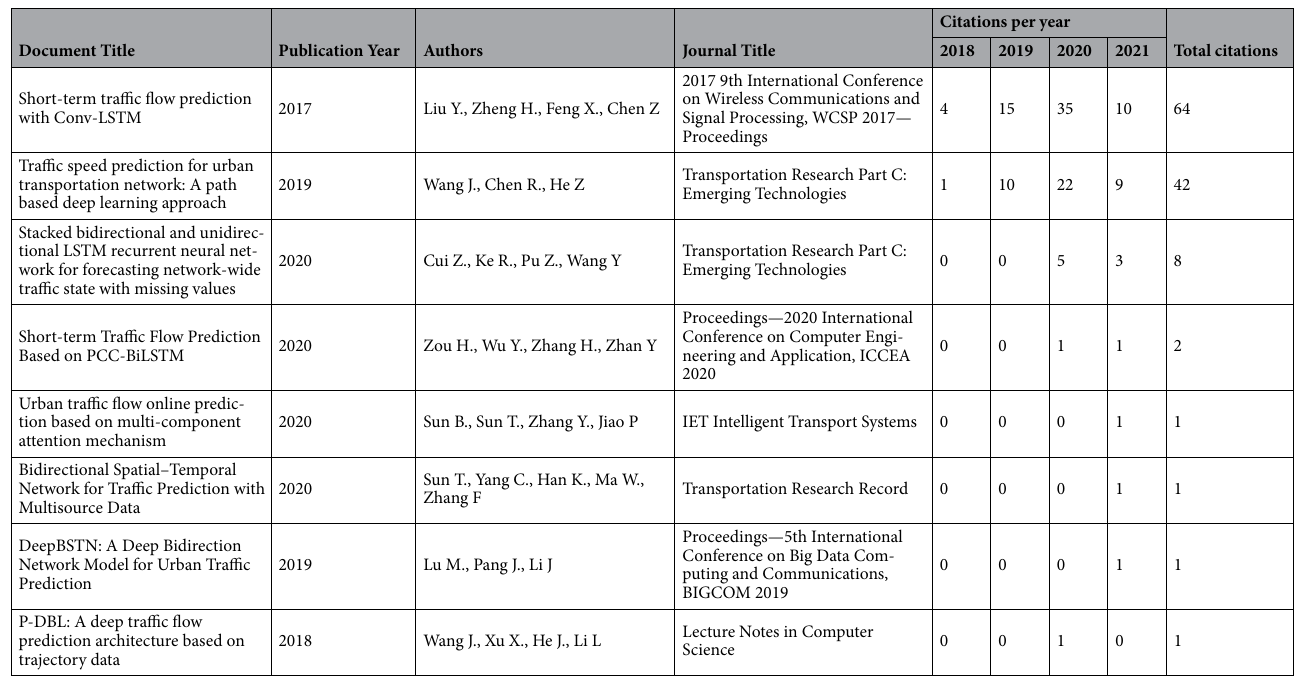
Table 1. Top cited documents using bilstm